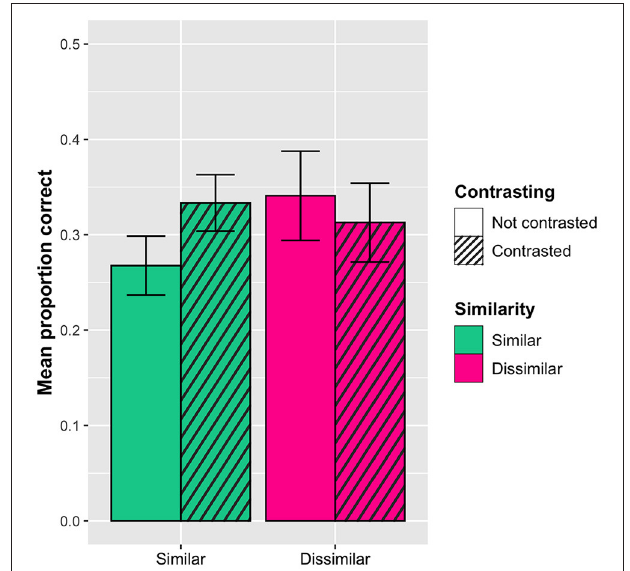
FIGURE 6 | Interaction effect on the post-tests between sorting and similarity (orthographic and semantic similarity collapsed) with 95% confidence interval bars. The similar words are remembered significantly better when they have been contrasted than when they have not.